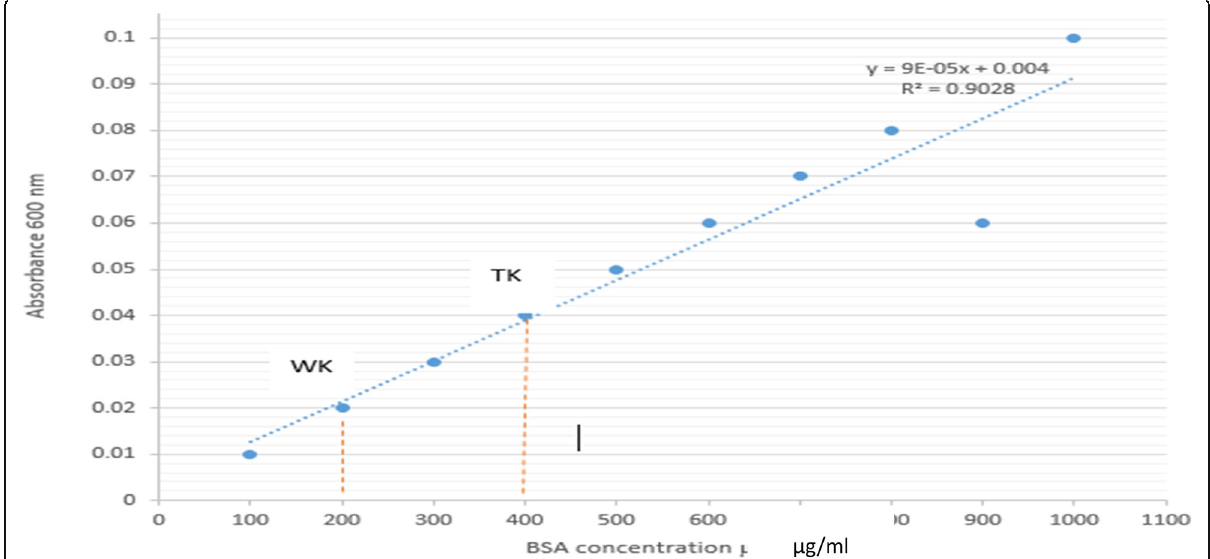
Fig. 2 Standard curve for Lowry method .The curve was made using bovine serum albumin (BSA) as a standard protein with graduate concentrations (100 to 1000 μ g/ml). TK represents the concentration of 0.04 mg/ml value and WK represents the concentration of 0.02 mg/ml value